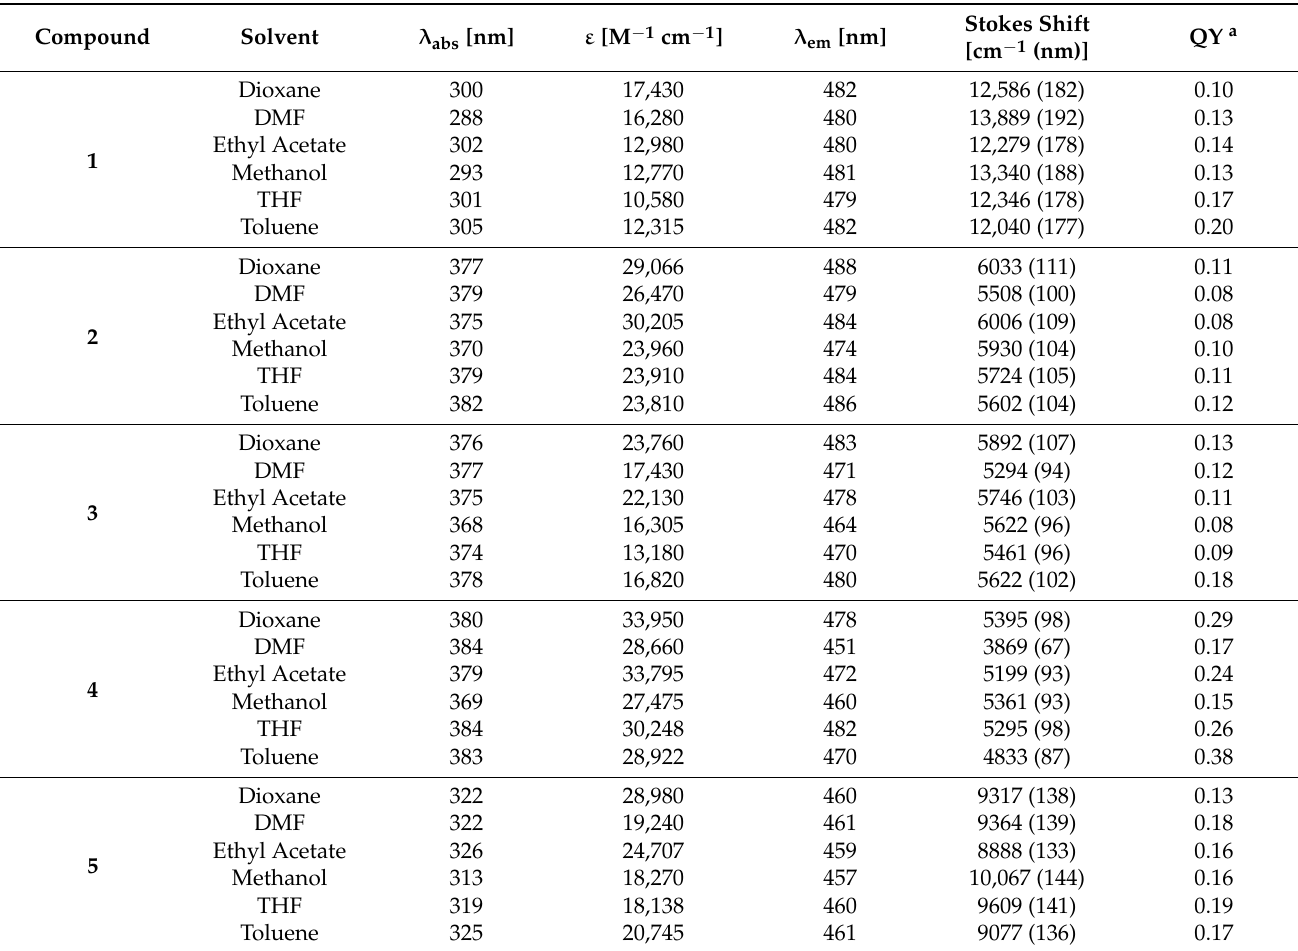
Table 1. Solvatochromic properties of probes 1 – 5